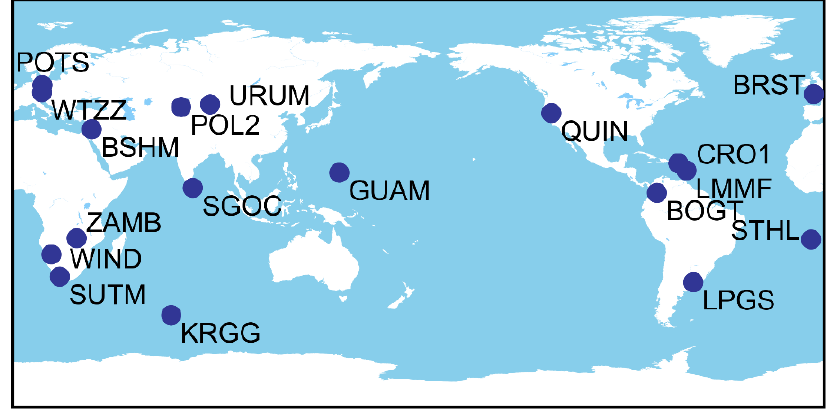
Figure 2. Distribution of selected